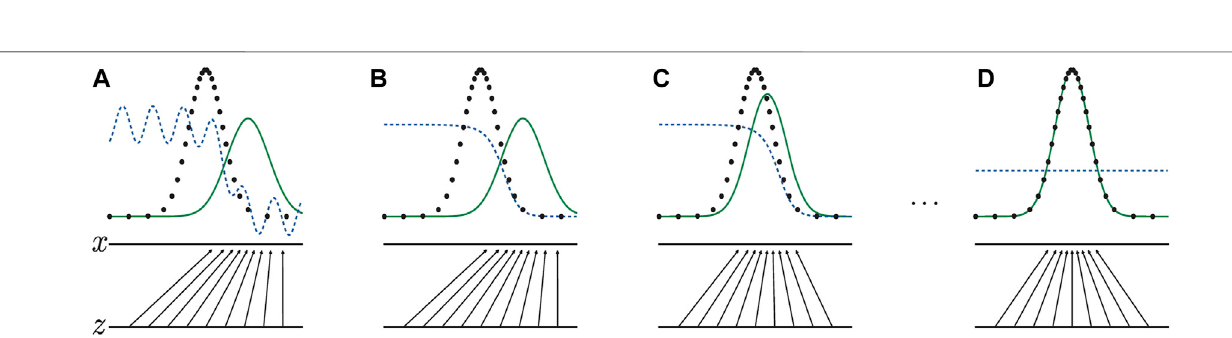
Frontiers in Earth Science |